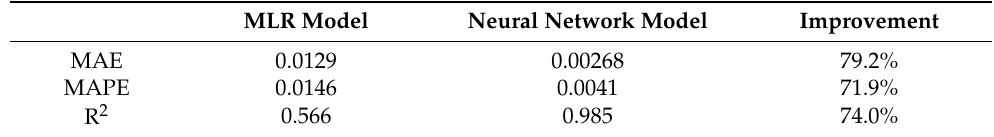
Figure 11. The training results and prediction results by the NN and MLR: ( a ) Multi linear regression results, ( b ) Neural network results. Table 5. Neural network prediction model performance, compared with MLR